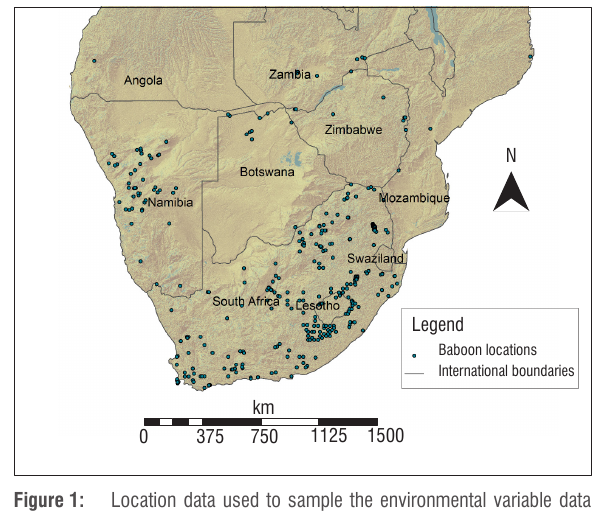
Figure 1: Location data used to sample the environmental variable data sets in order to model the environmental central niche of the chacma baboon in southern Africa. Figure 2: Layers depicting areas satisfying the criteria for each environ-